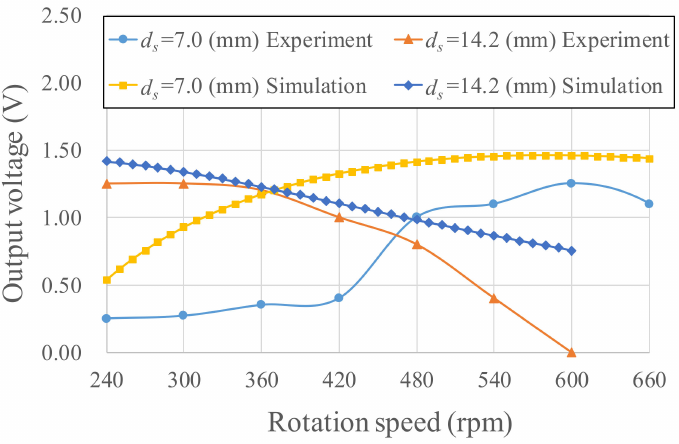
Figure 22. Simulated and experimental voltage of the proposed energy harvester.